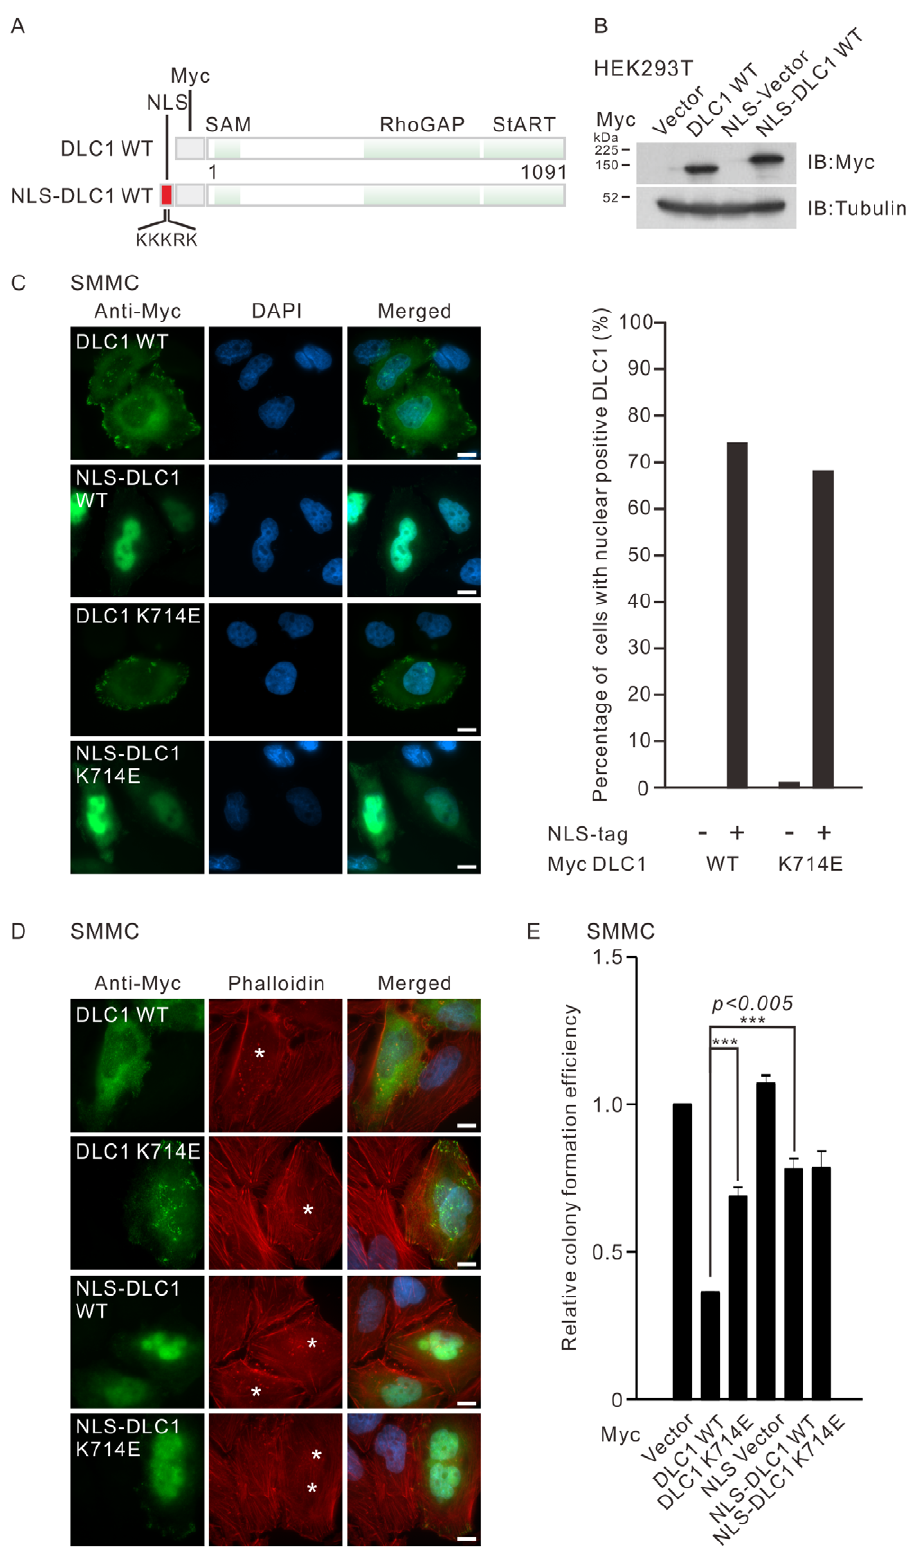
Figure 4. Transiently expressed nuclear-targeted DLC1 exhibited reduced activity in suppressing actin fiber formation and colony formation. ( A ) Schematic diagram showing the structure of the nuclear targeted DLC1 (NLS-DLC1) used for transient expression experiment. The DNA sequence encoding the monopartite NLS which consists of five basic amino acids KKKRK were inserted in front of the open reading frame of Myc-tagged DLC1. Translation of the manipulated expression construct encoded Myc-tagged NLS-DLC1. ( B ) HEK293T lysates with overexpressed Myc-tagged DLC1 or NLS-DLC1 were immunoblotted with anti-Myc antibody. ( C ) SMMC-7721 cells were transiently transfected with the indicated